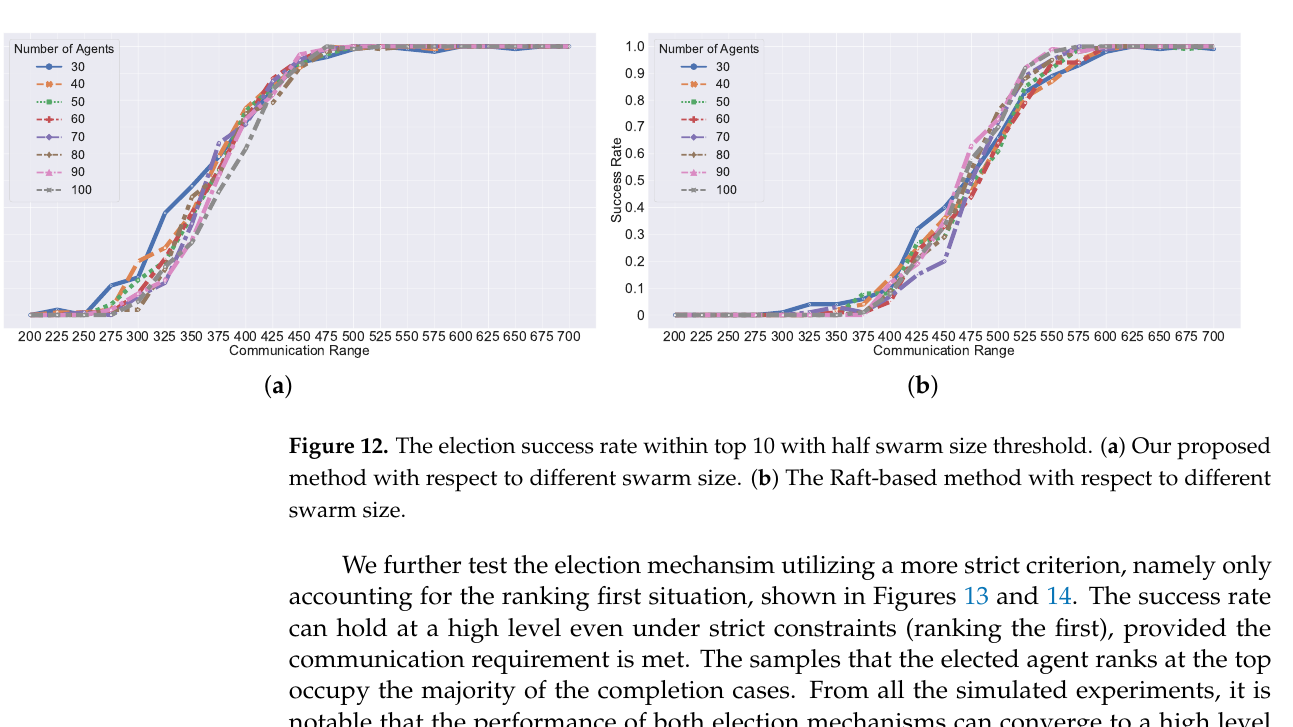
Figure 11. The election success rate within top 10 with 15-vote threshold. ( a ) Our proposed method with respect to different swarm size. ( b ) The Raft-based method with respect to different swarm size.